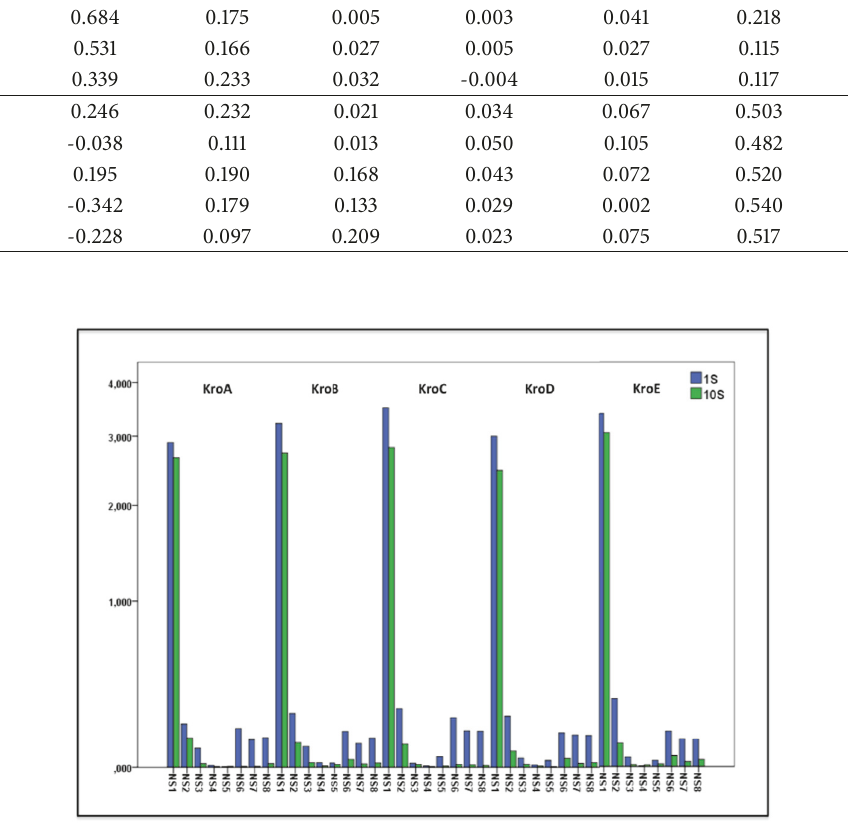
Figure 5: Comparison of the 1 and 10 results for SA.